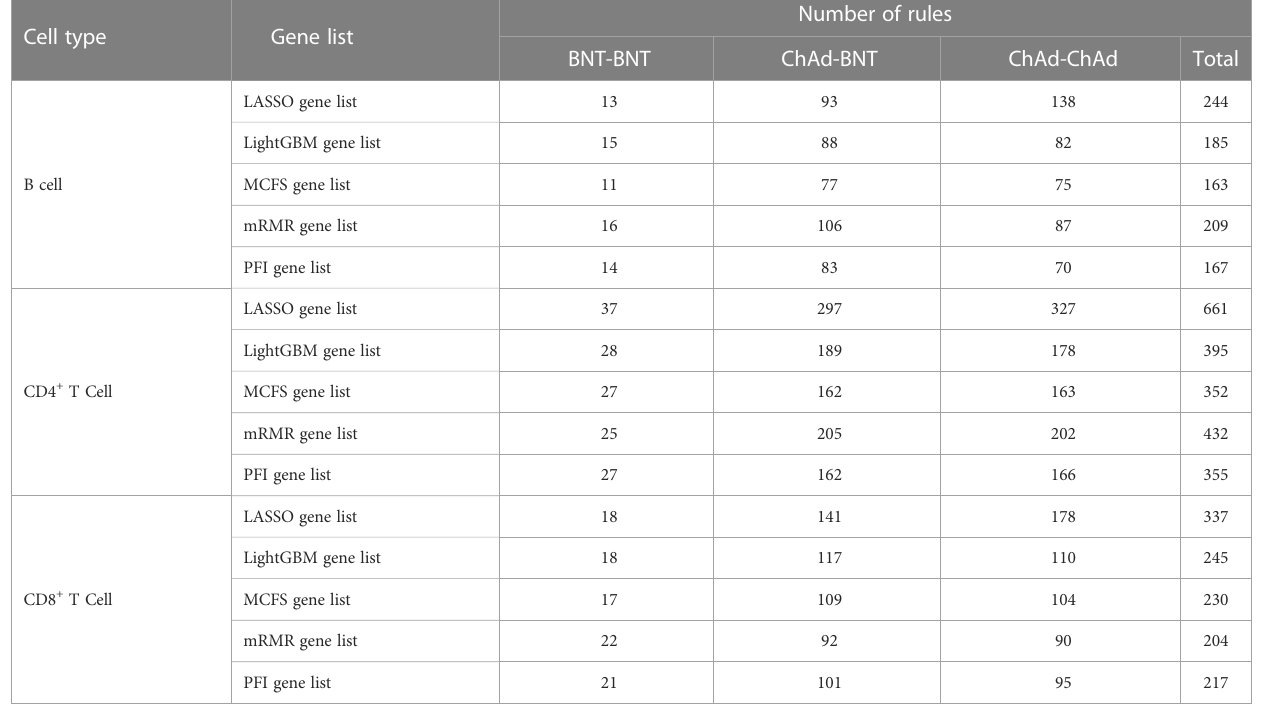
TABLE 5 Breakdown of rules yielded by decision tree on different gene lists for each cell